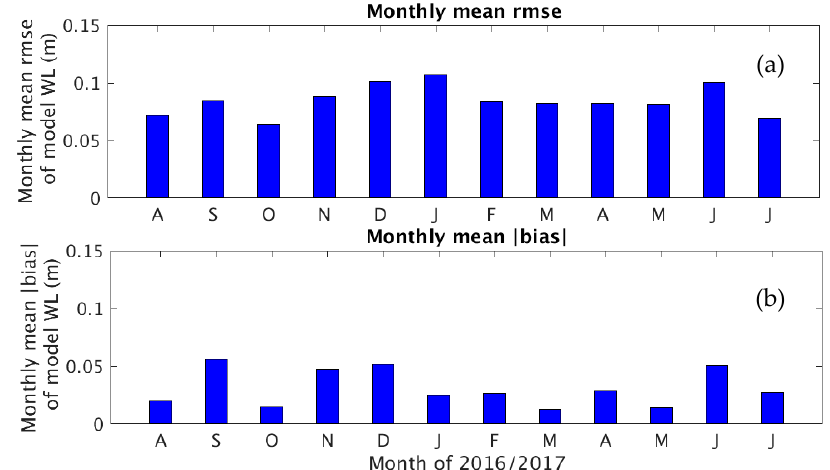
Figure 10. Monthly means of ( a ) the root-mean-square errors (RMSE) and ( b ) absolute model-data differences (|bias|) of the hindcast total water level.